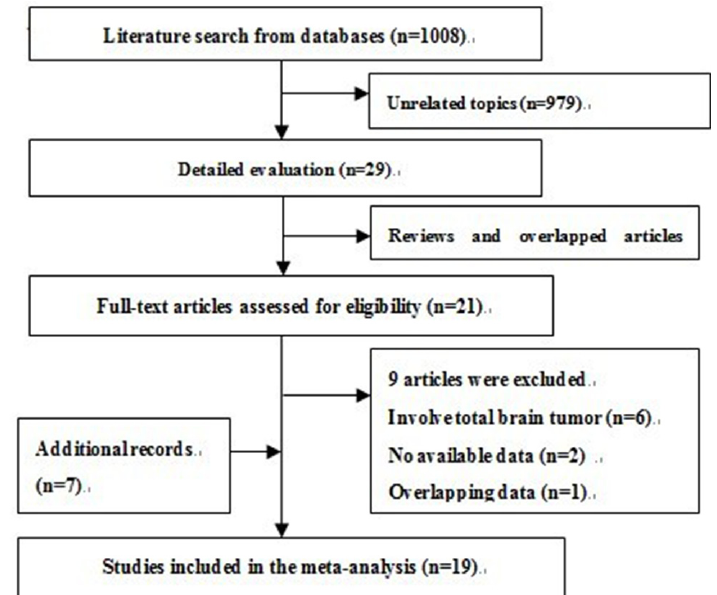
Figure 1. Flow diagram of study